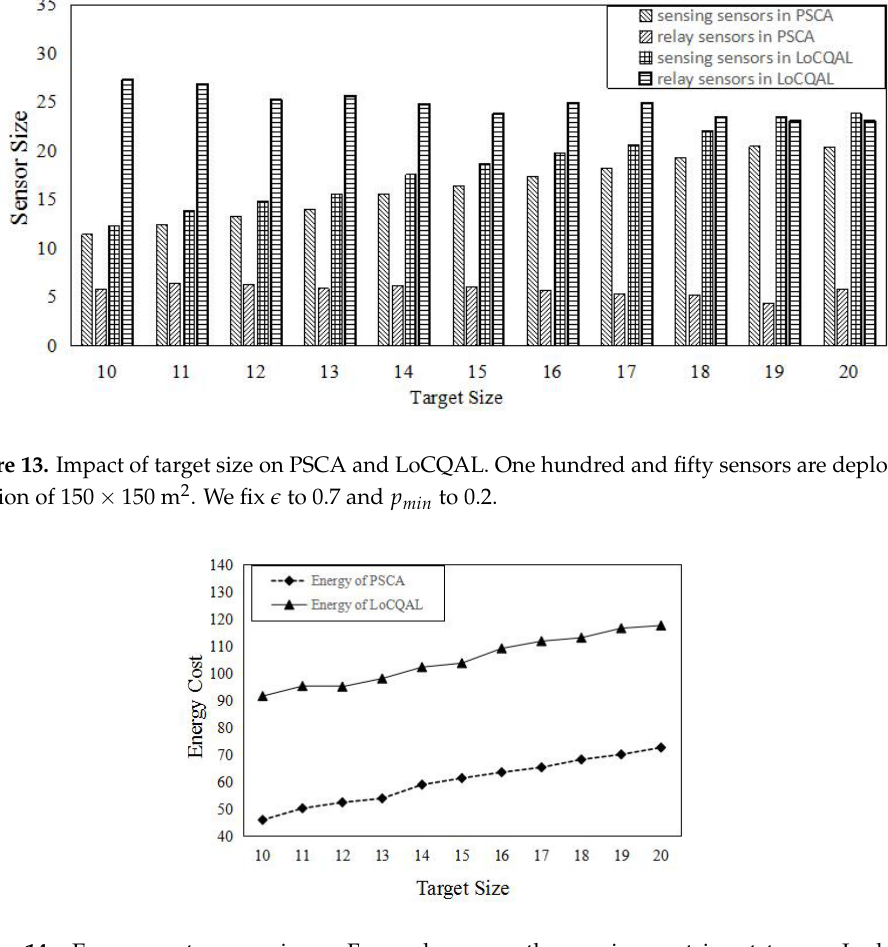
Figure 14. Energy cost comparison. For each sensor, the sensing cost is set to one Joule, and communication cost is two